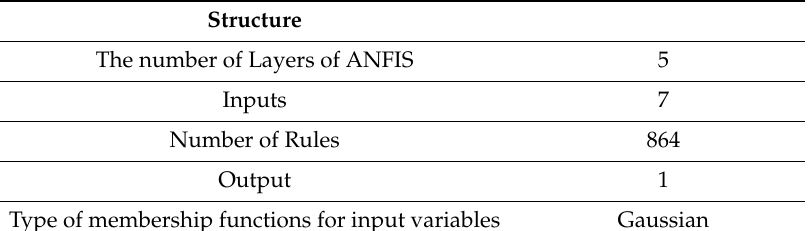
Table 7. Structure of ANFIS for renal cancer.